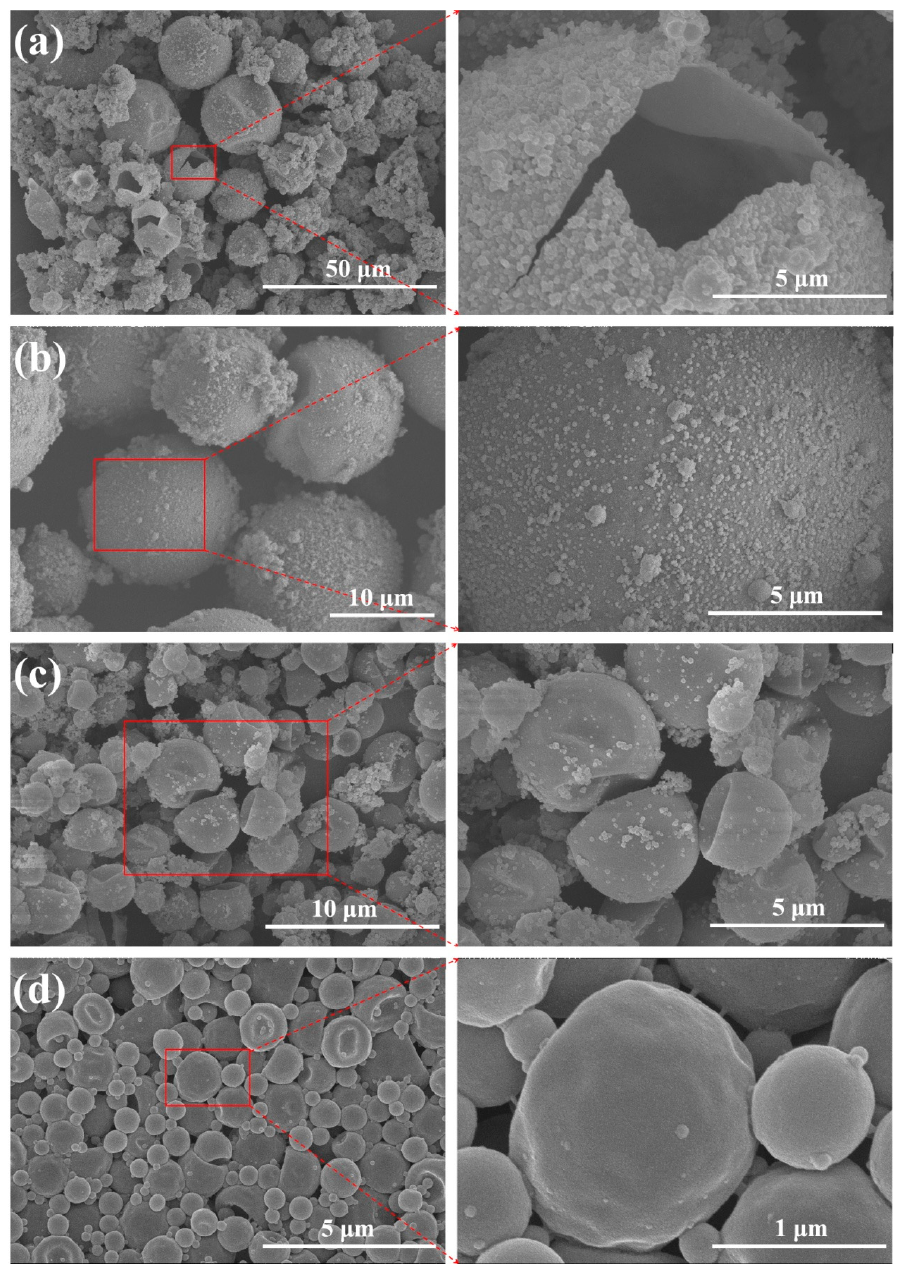
Figure 3. SEM micrographs of Micro/NanoPCMs containing n- dodecanol with various concentration of SMA: ( a ) 5.0 wt %; ( b ) 6.7 wt %; ( c ) 10.0 wt %; and ( d ) 15.0 wt %.